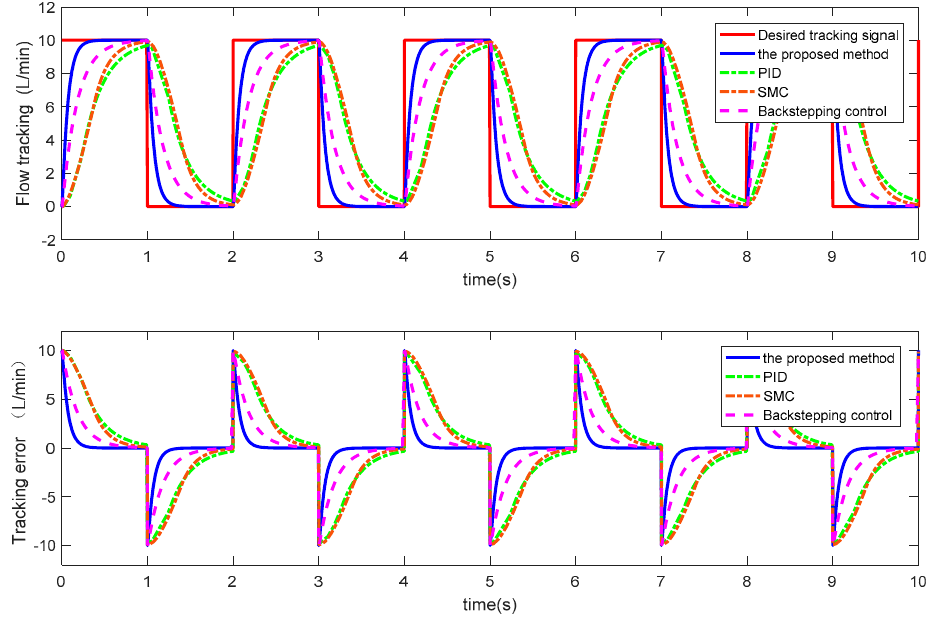
Figure 10. Time response of glue flow tracking and tracking error.